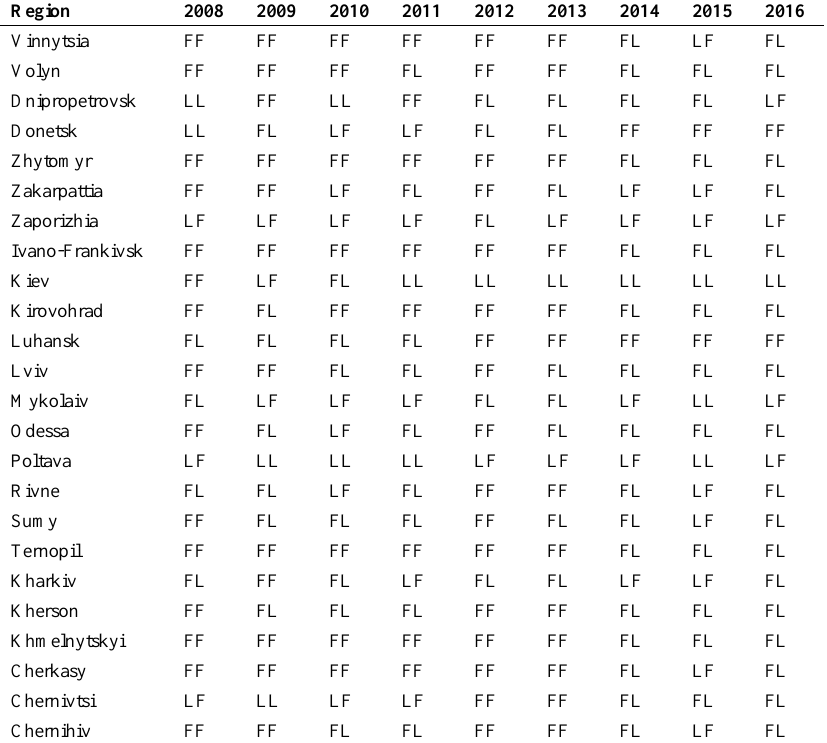
Table 3. Affiliation of the regions in Ukraine to different attributive groups according to their level of sustainable development